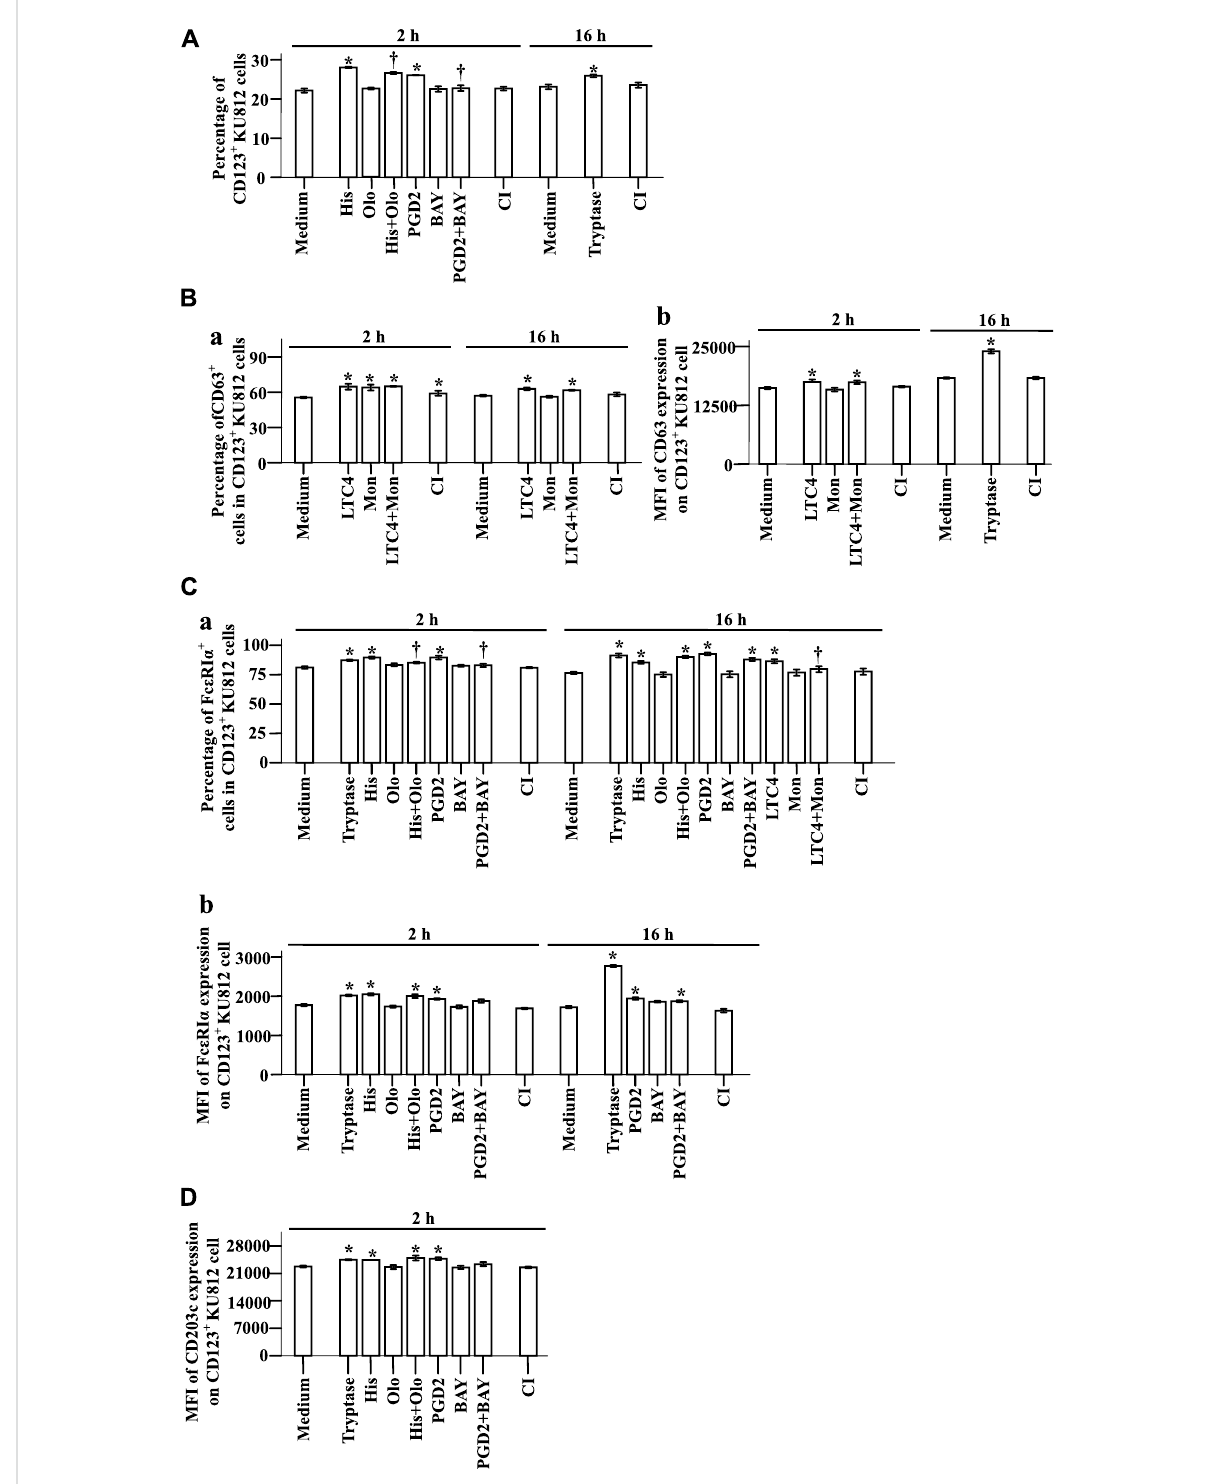
FIGURE 7 ExpressionofCD123,CD63,CD203c,andFc ε RI α onKU812cells.Thecellswereincubatedwithtryptase(1.0 μ g/ml),histamine(1.0 μ g/ml),olopatadine hydrochloride (Olo, 10.0 μ g/ml), prostaglandin D2 (PGD2, 0.1 μ g/ml), BAY-u-3405 Ramatroban (BAY, 0.35 μ g/ml), leukotriene C4 (LTC4, 300 nM), montelukast sodium (Mon, 900 nM), calcium ionophore (CI, 1.0 μ M), or PBS (pH 7.4) for 2 or 16 h at 37 ° C. (A) percentages of CD123+ KU812 cells at 2 and 16 h following incubation. (B) and (C) CD63 and Fc ε RI α expression on CD123+ KU812 cells. (a) percentages of CD63+ or Fc ε RI α cells in CD123+ KU812cellsand (b) MFIofCD63orFc ε RI α expressiononCD123+KU812cellsat2and16 hfollowingincubation. (D)